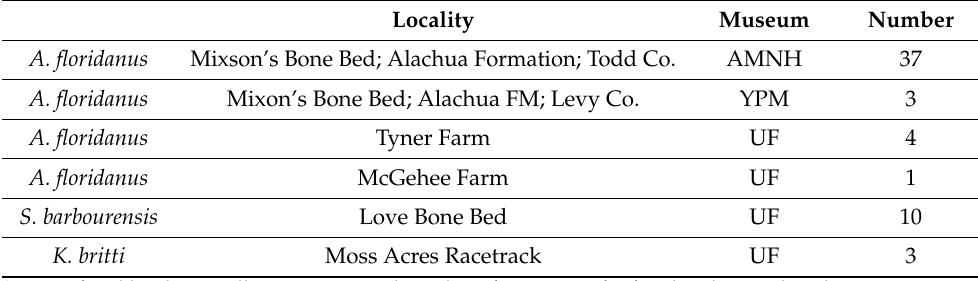
Table 1. Molar specimens analyzed.